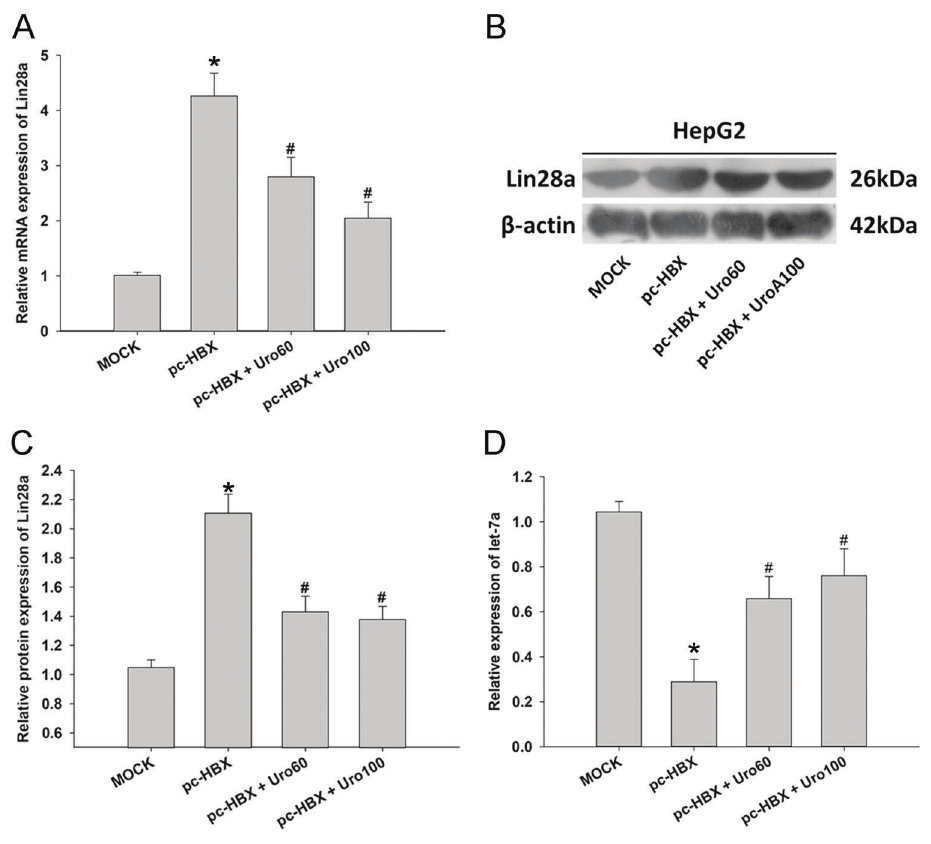
Figure 3. Urolithin A downregulated Lin28a expression and elevated the expression of let-7a in HBX overexpressed hepatocellular carcinoma HepG2 cells. Urolithin A suppressed Lin28a mRNA expression ( A ) and protein expression ( B and C ) in HBX-overexpressed HepG2 cells. D , Urolithin A elevated the let-7a expression in HBX-overexpressed HepG2 cells (qPCR). *P o 0.05 compared to the MOCK control. # P o 0.05 compared to the pc-HBX group